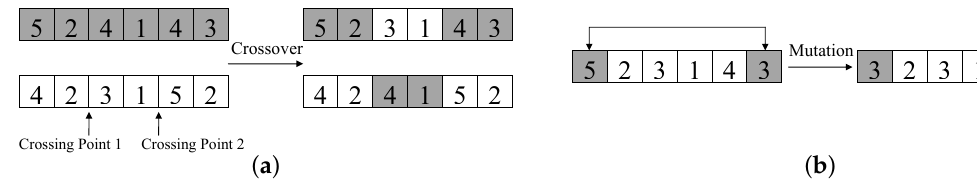
Figure 7. Genetic operations: illustration of ( a ) two-point crossover and ( b )